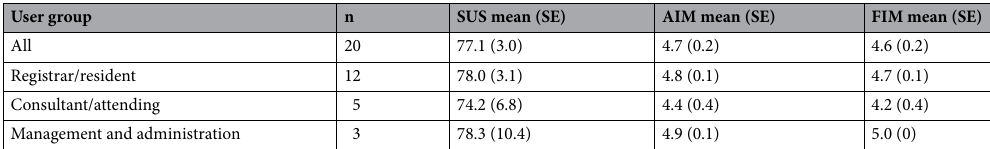
Table 2. Usability, feasibility and acceptability scores among main user groups. SUS system usability scale, scored out of 100, AIM acceptability intervention measure, scored out of 5, FIM feasibility intervention measure, scored out of 5, SE standard